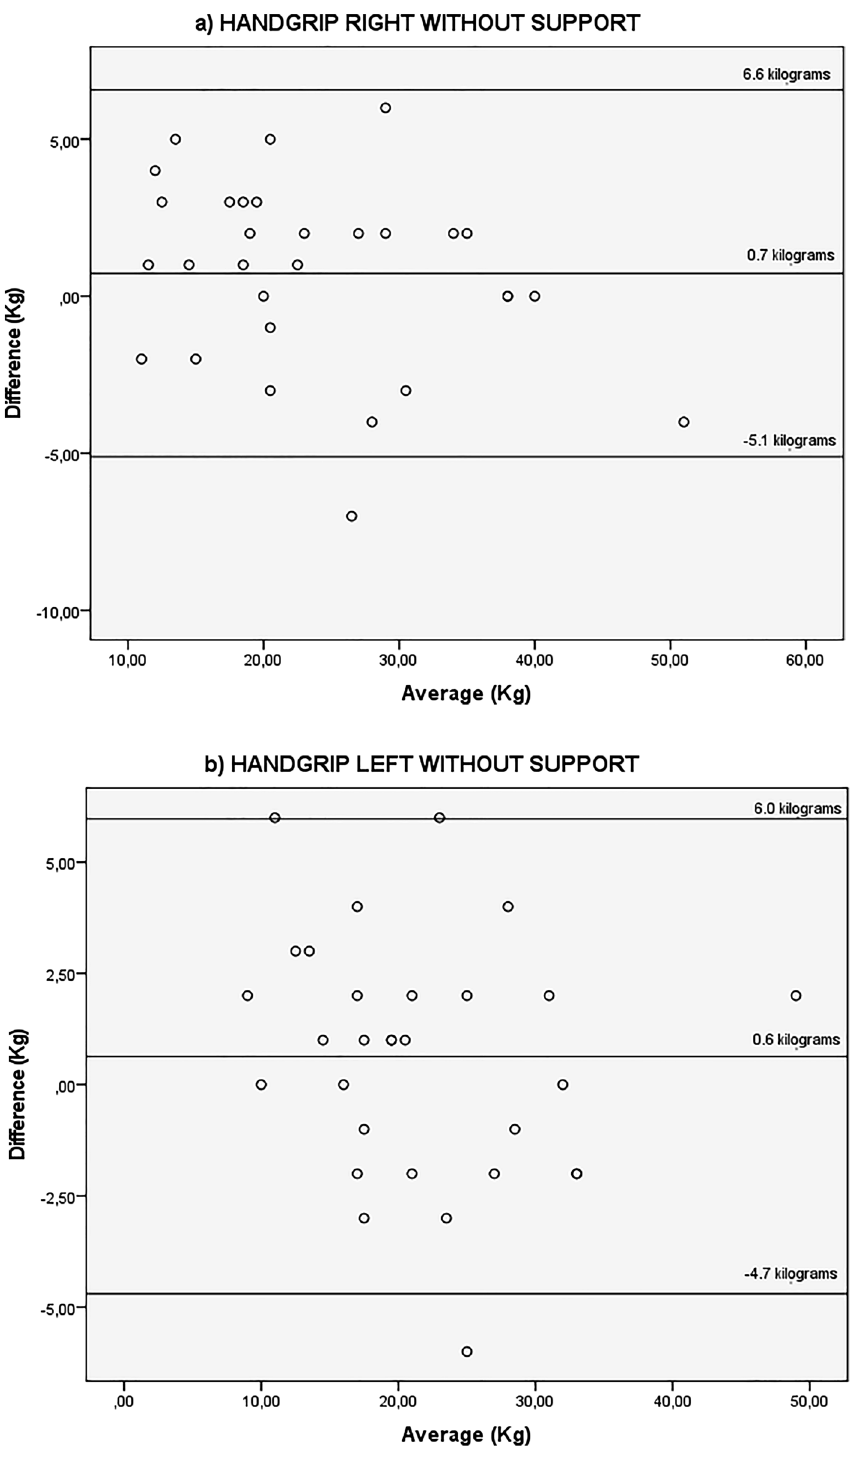
Figure 5. Bland–Altman plots showing agreement for the kilograms achieved with the handgrip strength test, right and left without support, obtained before the haemodialysis session and on a non-dialysis day by the same rater. Y axis difference between (non-dialysis—before the haemodialysis session) Kilograms X axis average (non-dialysis + before the haemodialysis session)/2